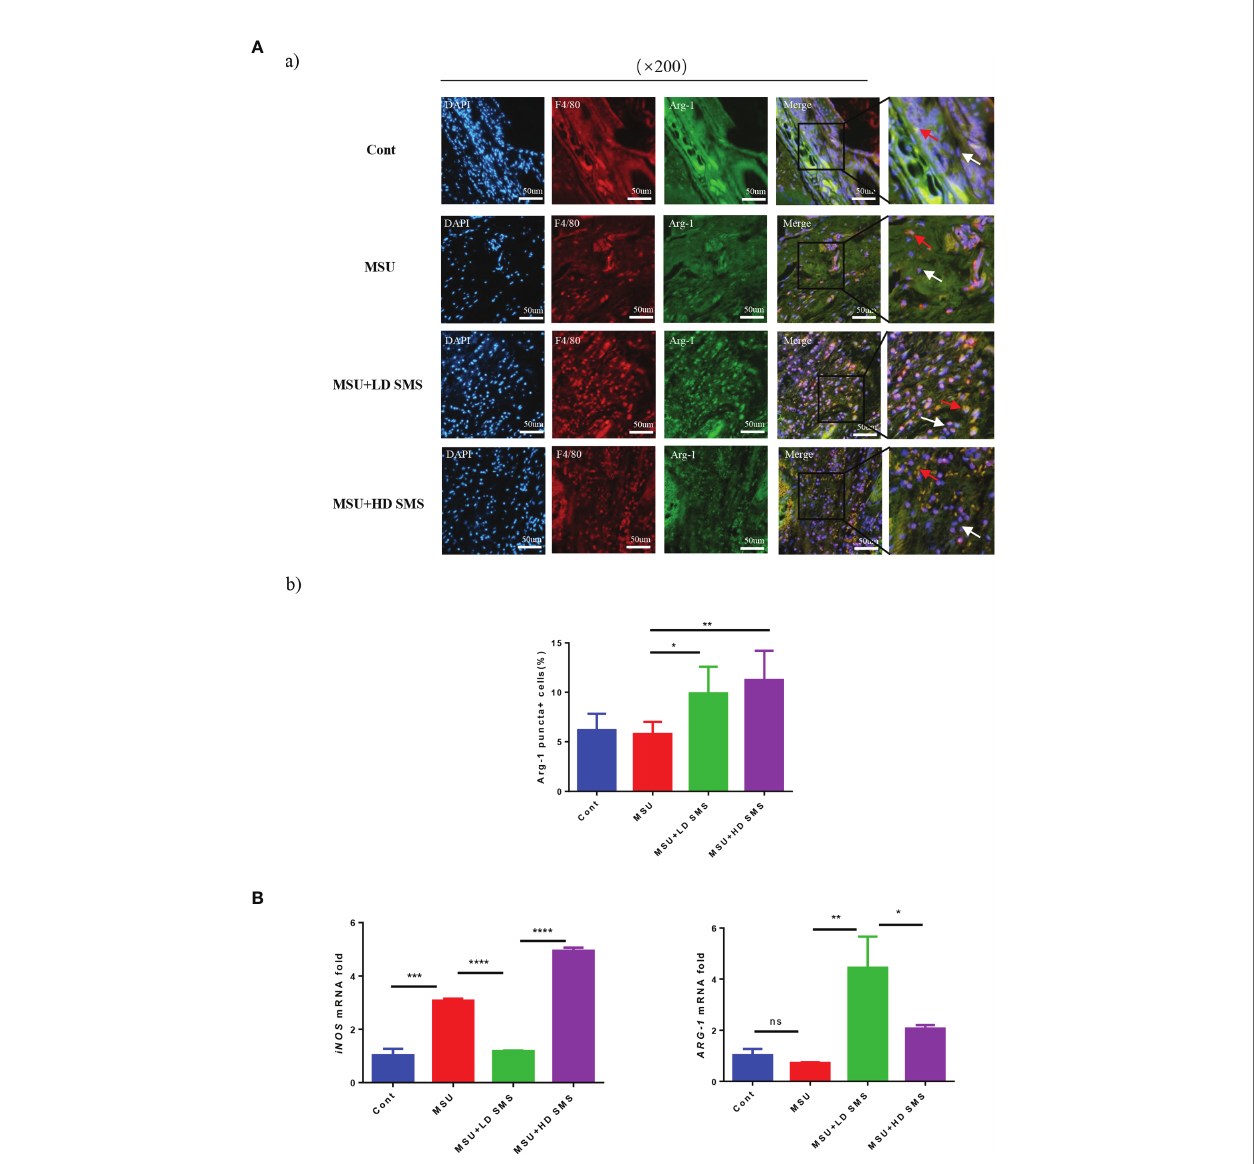
FIGURE 3 | SMS promote M2 macrophage polarization. IF co-localization staining of F4/80, Arg-1, DAPI in joint sections of mice were performed to estimate macrophage polarization (Aa) , the red arrows represent F4/80 + /Arg-1 + cells, white arrows represent F4/80 + /Arg-1 - cells. The F4/80 + /Arg-1 + cells were counted (Ab) . The mRNA expression of ARG-1 and iNOS were detected by RT-PCR (B) . (mean ± SEM. ns p > 0.05, *p < 0.05, **p < 0.01, ***p < 0.001, ****p < 0.0001; n = 6/group; LD SMS: 1mg/kg.day low dose SMS; HD SMS:10mg/kg.day high dose